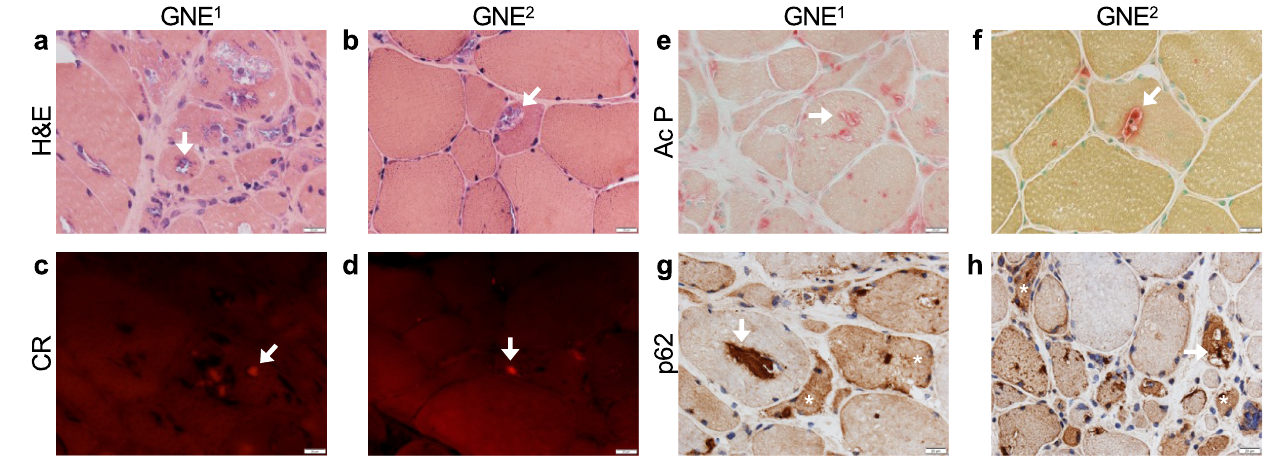
Fig. 1 Characterization of GNEM patient muscle biopsies. a , b Hematoxylin and eosin (H&E) stained tissue cross-sections of two patients with GNE myopathy, GNE 1 (left) and GNE 2 (right), exhibit rimmed vacuoles (arrows) and muscle fi ber size variability. c , d Congo Red stained sections highlighting the presence of congophilic inclusions (arrows). e , f Acid phosphatase over-reactivity within vacuoles (arrows) and in a punctuate fashion outside the vacuoles, suggesting lysosomal dysfunction. g , h Ectopic p62 immunoreactivity occurs focally (arrow) or diffusely (asterisk) in numerous muscle fi bers. a – h images are ×40, scale bars: 20